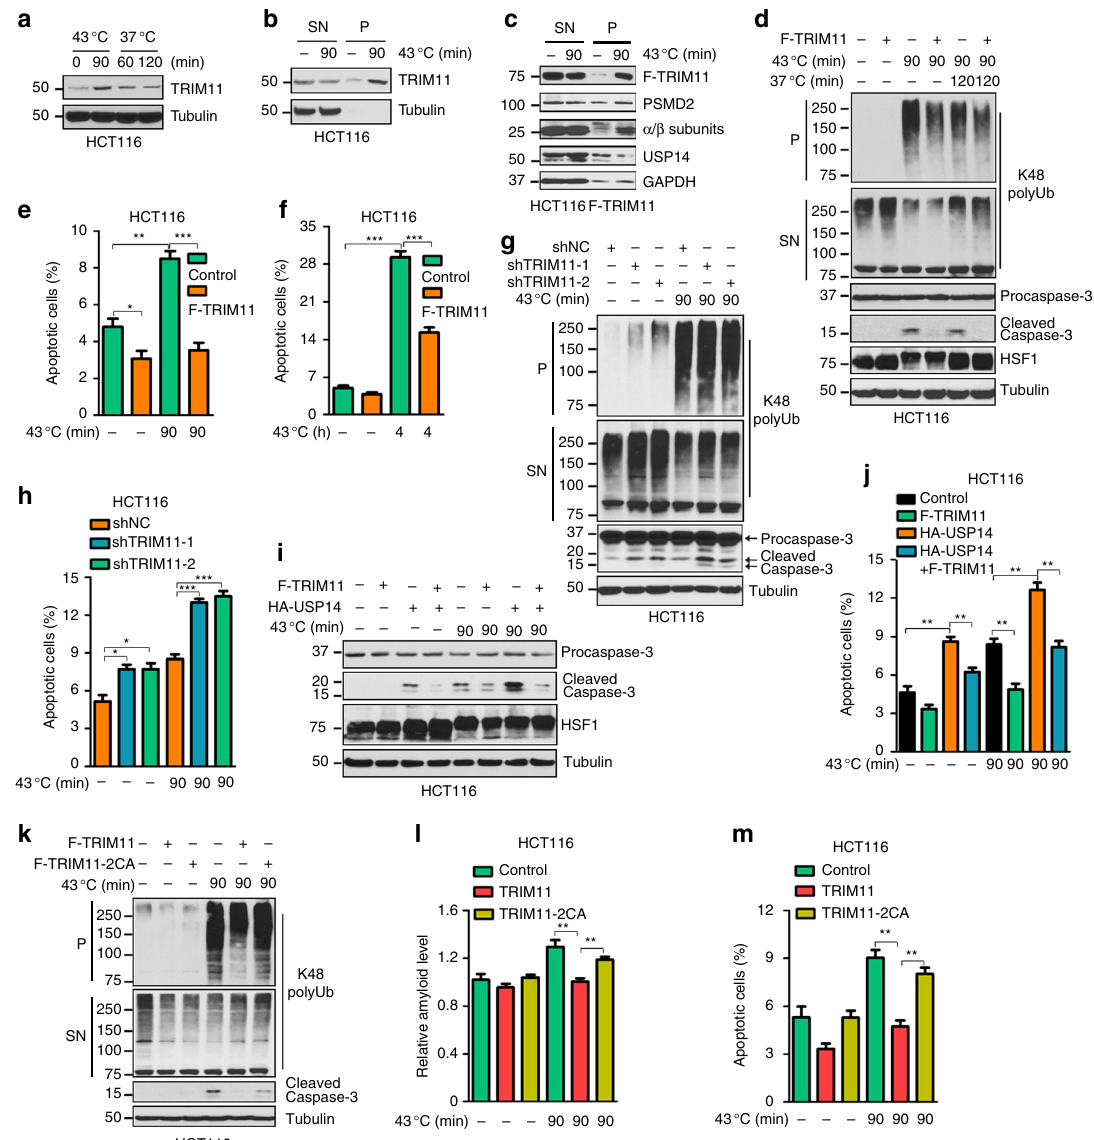
Fig. 7 Role of the TRIM11-USP14 axis in cell growth and apoptosis. a Levels of endogenous TRIM11 in HCT116 cells grown at 43 °C for 0 or 90 min, or at 43 ° C for 90 min, and then at 37 °C for 60 or 120 min. b , c Levels of endogenous TRIM11 ( b ), or Flag-TRIM11, the indicated proteasome subunits, and USP14 ( c ) in the SN and P fractions of HCT116 cells with and without heat shock at 43 °C for 90 min. d , g TRIM11 overexpression ( d ) or knockdown ( g ) HCT116 cells and the corresponding control cells grown under unstressed, heat shock, and heat shock plus recovery conditions were analyzed for K48 polyUb conjugates and caspase-3 activation. e , f , h Apoptosis in TRIM11 overexpression ( e , f ) or knockdown ( h ) HCT116 cells, and the corresponding control HCT116 cells, treated with and without heat shock. i , j Caspase-3 activation ( i ) and apoptosis ( j ) in HCT116 cells expressing the indicated proteins and grown under normal or heat stress conditions. k – m K48 polyUb conjugates, caspase-3 activation ( k ), amyloid-like fi brils ( l ), and apoptosis ( m ) in HCT116 cells expressing the indicated proteins and grown under normal and heat stress conditions. In e , f , h , j , l , and m , data represent mean ± SEM ( n = 3 unless otherwise indicated). * P < 0.05; ** P < 0.01; *** P < 0.001. Uncropped blots are presented in Supplementary Fig.